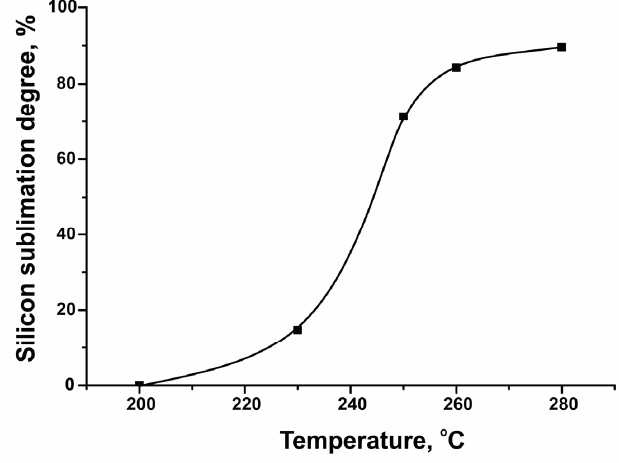
Figure 3. Influence of temperature on silicon fluoride sublimation.